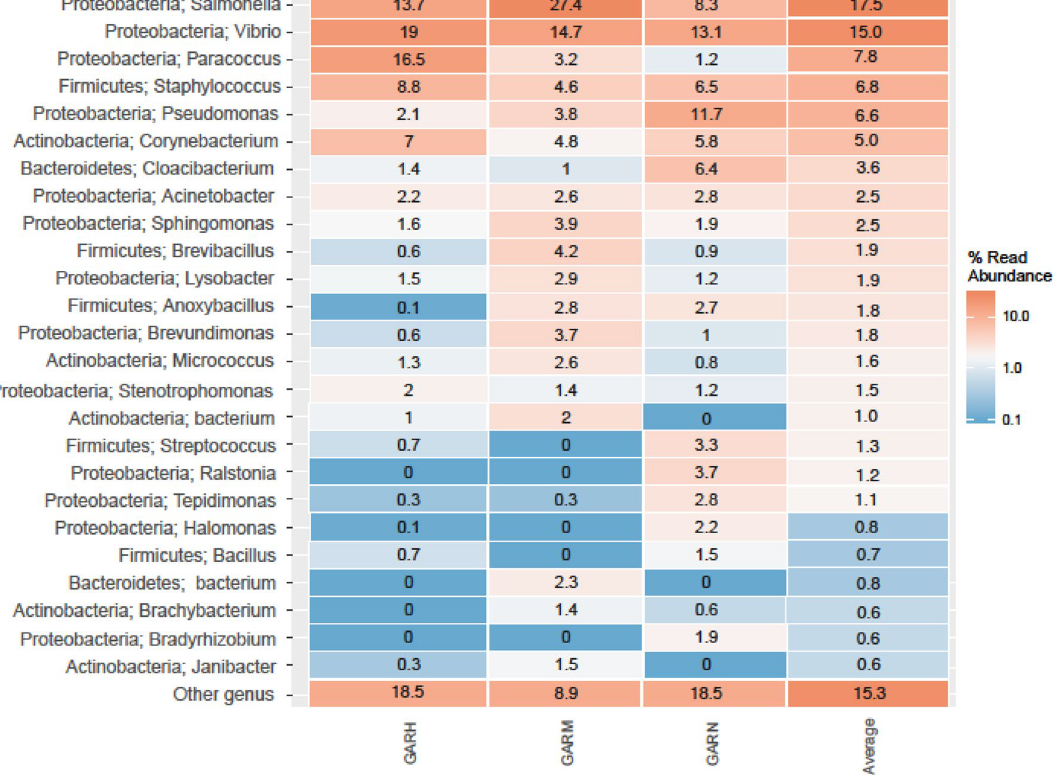
Figure 2. Microbiome abundance according to R. microplus stage and sex . (Rstudio version 3.2.3. https:// cran. rstud io. com/ bin/ windo ws/ base/ old/3.